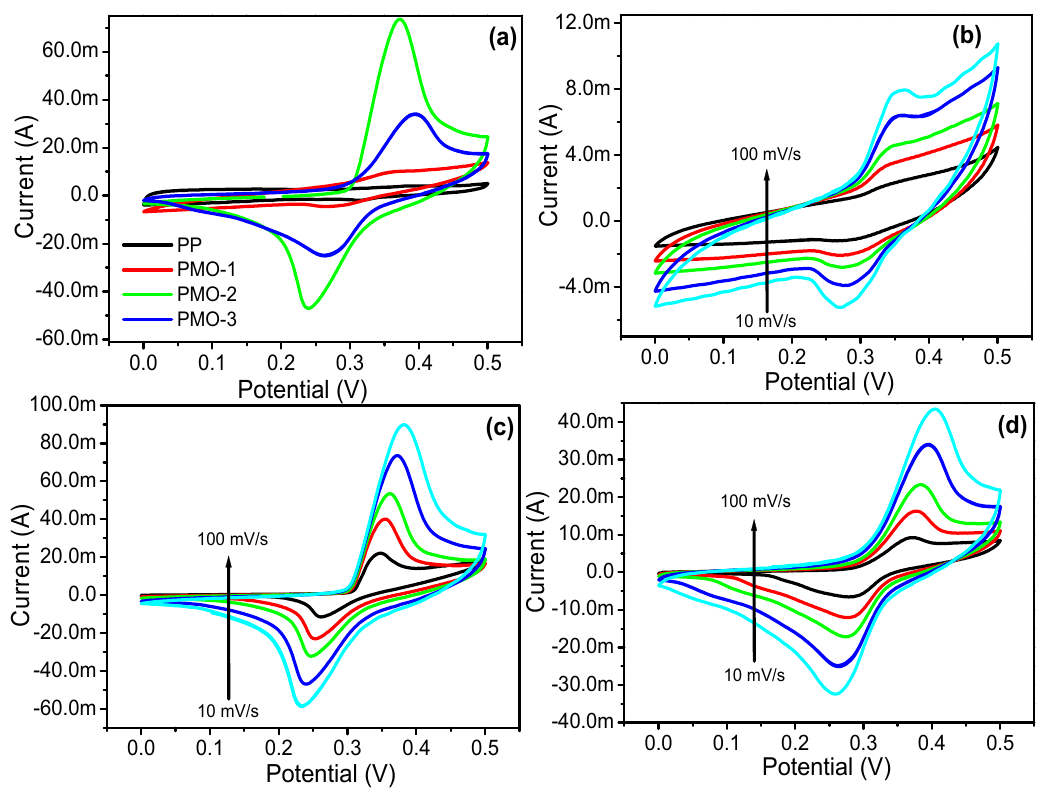
Figure 4. ( a ) Comparative CV graph of PP, PMO-1, PMO-2, and PMO-3 at a fixed scan rate, ( b ) CV graph of PMO-1 at different scan rates, ( c ) CV graph of PMO-2 at different scan rates, and ( d ) CV graph of PMO-3 at different scan rates.